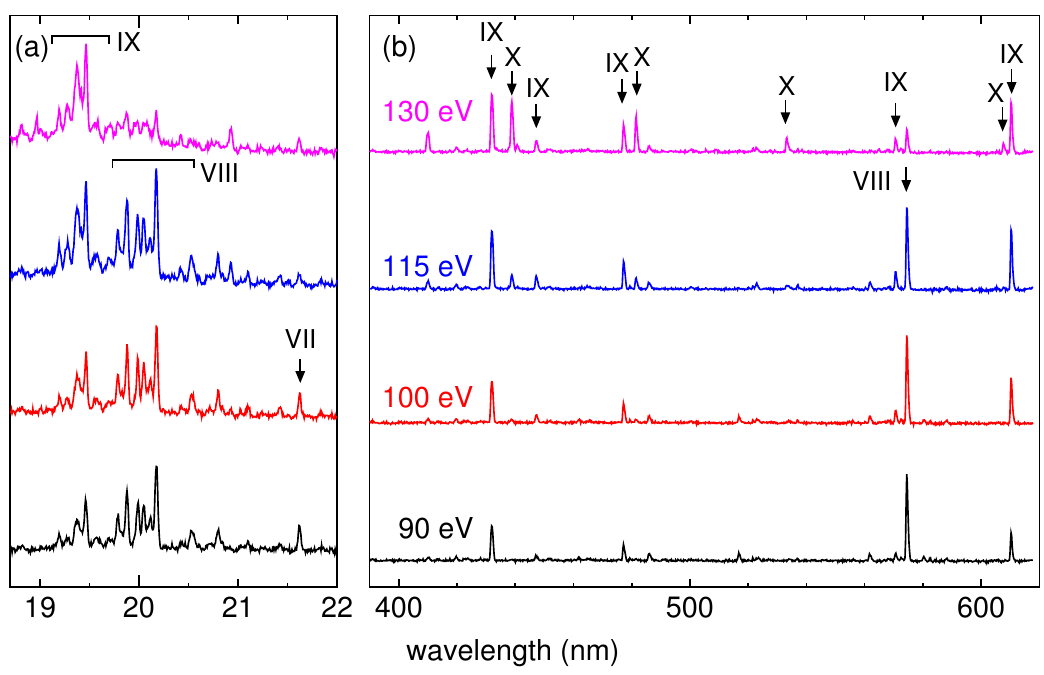
Figure 1. Spectra of tungsten ions in ( a ) the EUV range and ( b ) the visible range, obtained simultaneously at electron energies ( eV cd , see text) of 90 (black), 100 (red), 115 (blue), and 130 eV